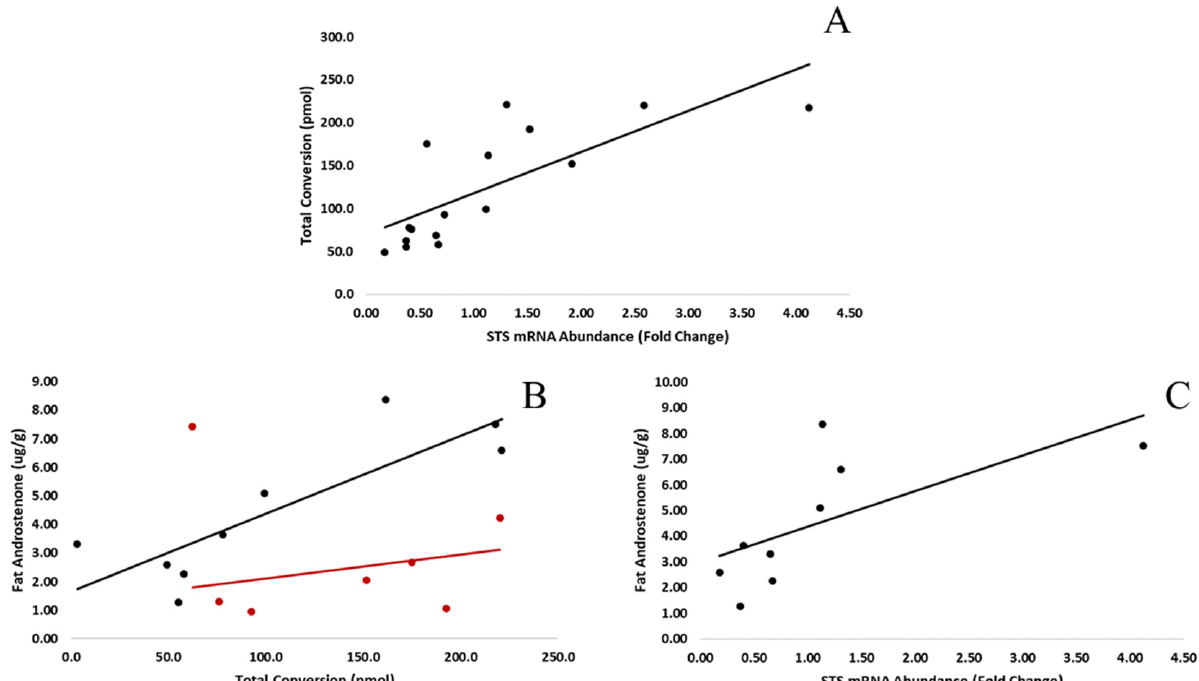
Figure 5. ( A ) The expression of STS in the fat was positively correlated (r = 0.76, p < 0.001) with the conversion of androstenone sulfate to free androstenone quantified by sulfatase assay ( n = 16). ( B ) Fat androstenone concentrations were positively correlated (r = 0.85, p < 0.001) with the conversion of androstenone sulfate to free androstenone quantified by sulfatase assay in early maturing boars (black, n = 9) but not late maturing boars (red, n = 7). ( C ) A positive trend (r = 0.67, p = 0.05) was observed between the expression of STS in the fat and the concentration of androstenone quantified in the fat in early maturing boars ( n = 9).